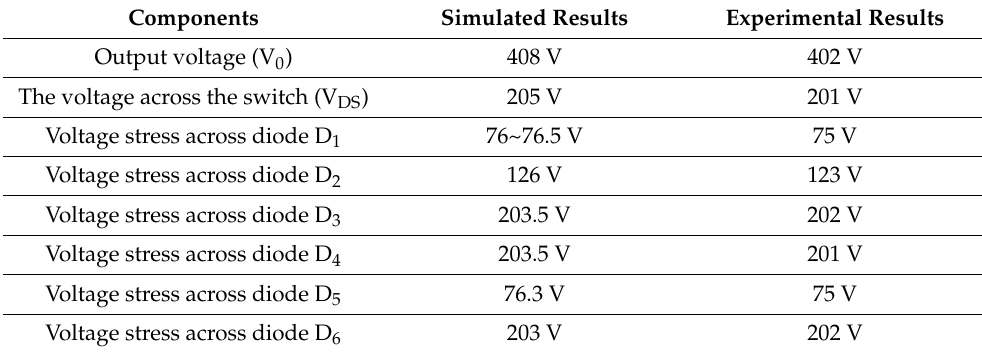
Table 3. Comparison table of voltage stress of simulated results and experimental results.